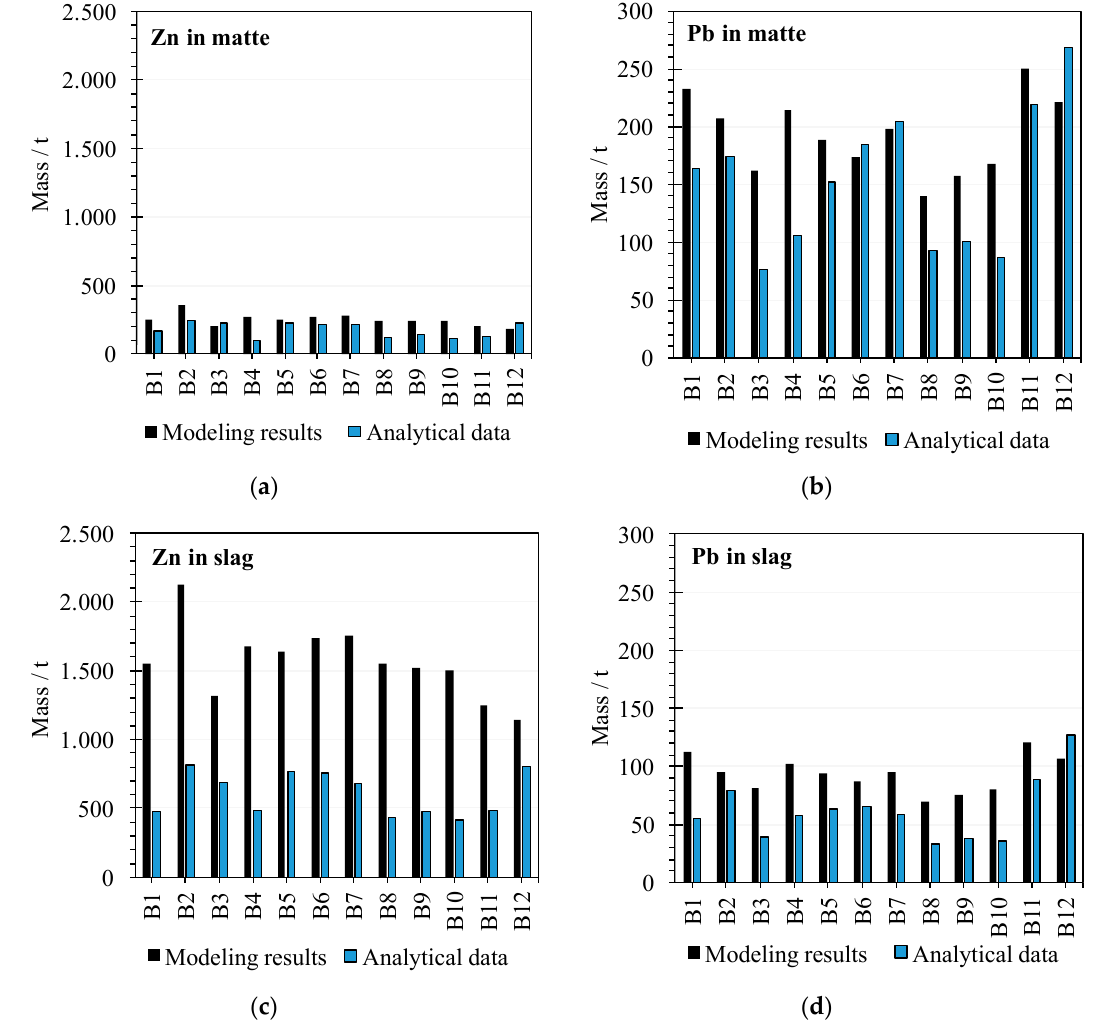
Figure 7. Minor elements (Pb, Zn) comparison. Mass of minor elements (in tons) corresponds to a monthly production. ( a ): Zn in matte, ( b ): Zn in slag, ( c ): Pb in matte, and ( d ): Pb in slag.